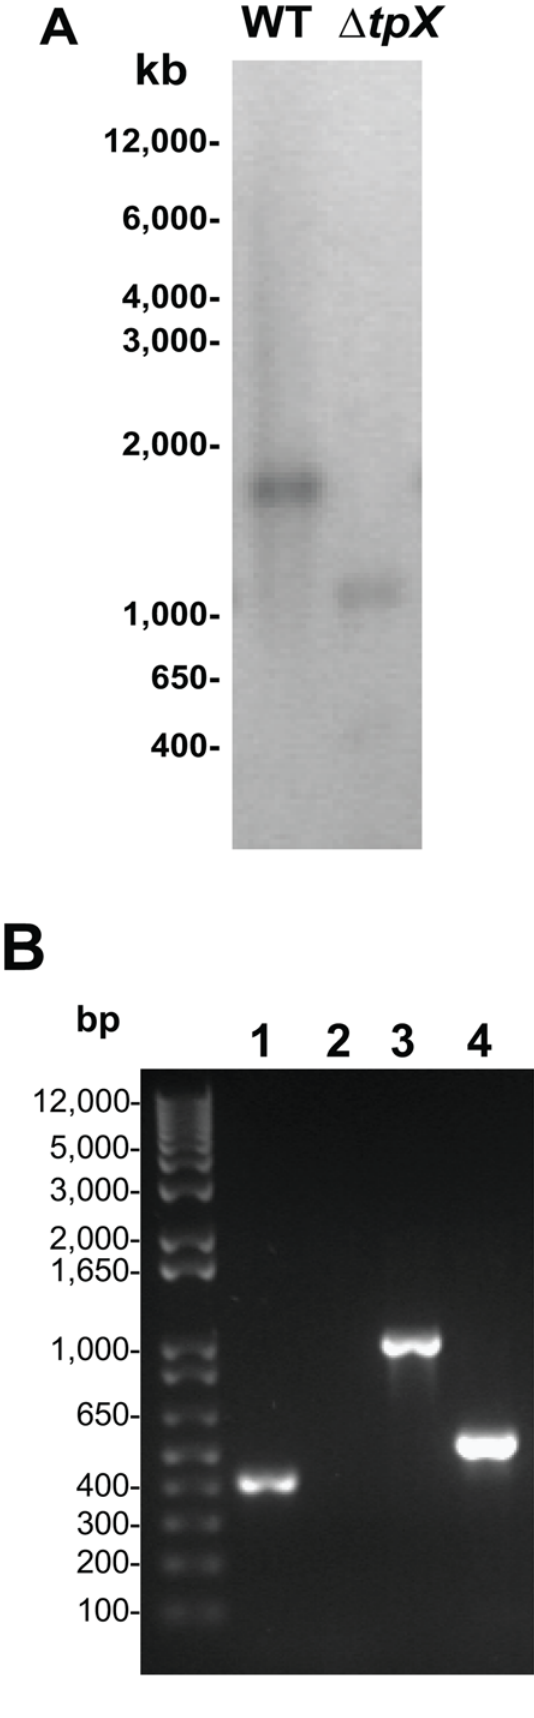
Figure 1. Confirmation of the M.tuberculosistpx gene deletion. A. Southern blotting analysis of DNA from the WT and the YH D tpx. which was digested with EcoRV and PvuI and hybridized with a probe synthesized to make the complemented construct. B. PCR amplification of DNA from the WT and the YH D tpx. 1. WT, 2. tpx mutant. The primers used were designed in the coding region of the tpx gene. 3. WT, 4. tpx mutant. The primers used were for the amplification of complemented construct. M, molecular weight marker (Invitrogen). The experiments were repeated twice, with identical results.